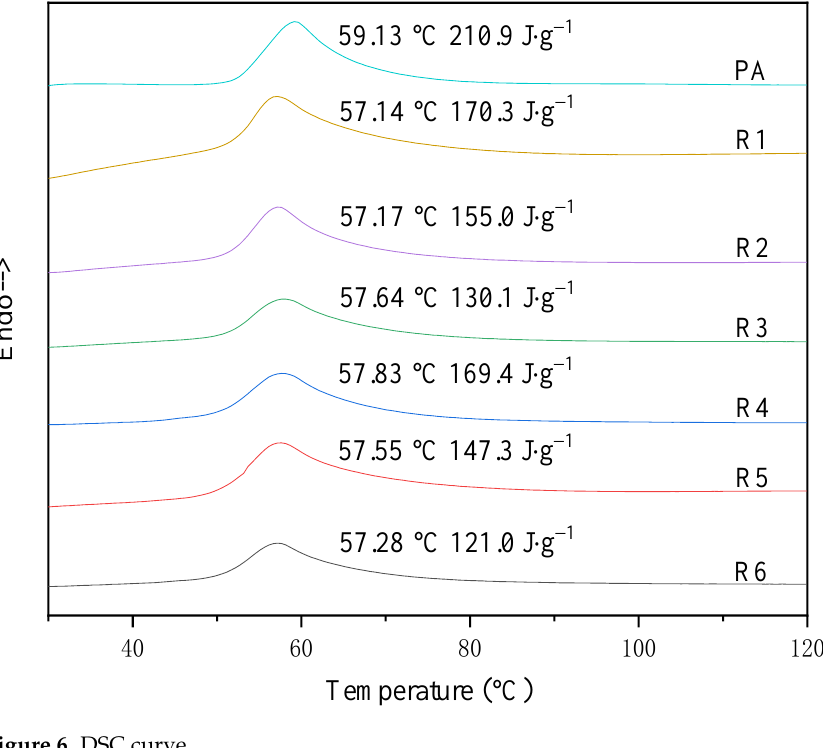
Figure 6. DSC curve.